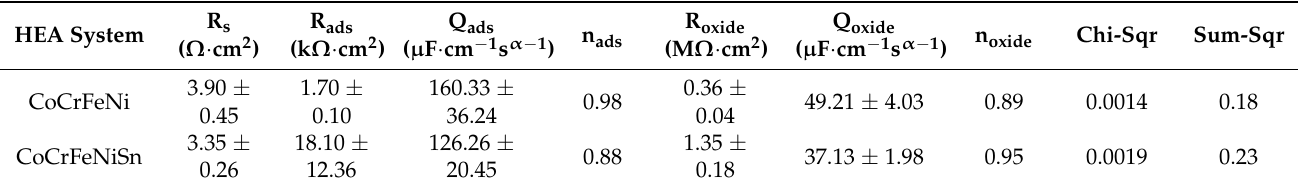
Table 4. EIS model parameters for CrFeCoNi and CrFeCoNiSn alloys in 0.6 M NaCl solution at ambient temperature. HEA System